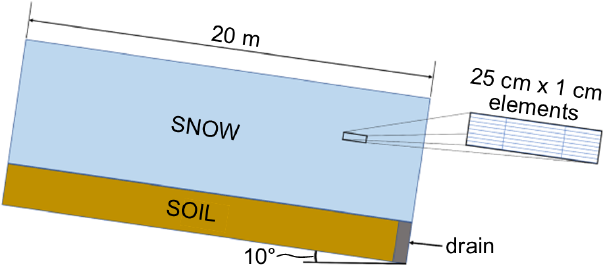
Figure 1. Conceptual diagram of the model domain showing the snowpack above soil, the location of the drain in the soil, and ele- ment discretization. Figure not to